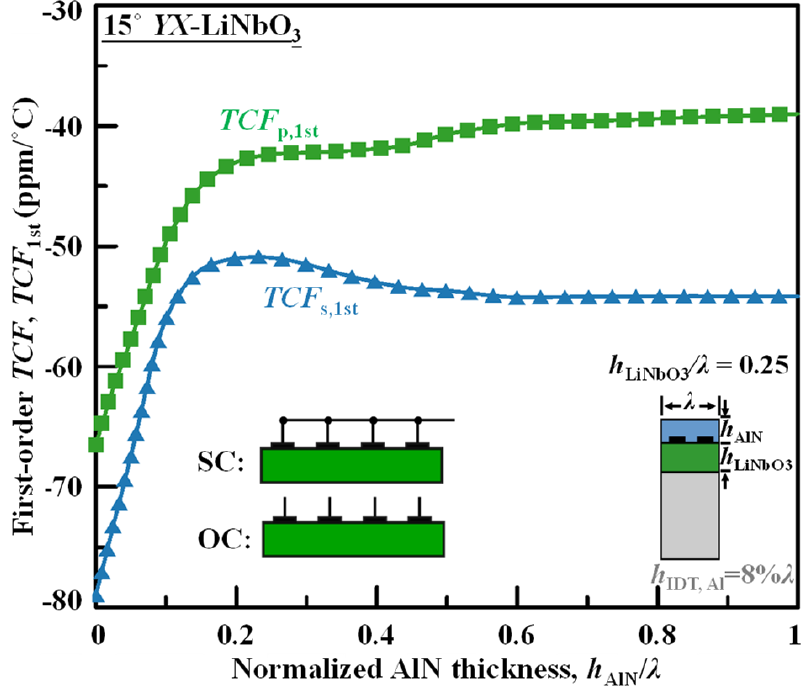
Figure 10. Calculated TCF s,1st and TCF p,1st by varying AlN thickness for the SH wave propagating in AlN/LiNbO 3 /Si. The inset depicts the short-circuited and open-circuited grating conditions, corresponding to resonance and parallel resonance, respectively.